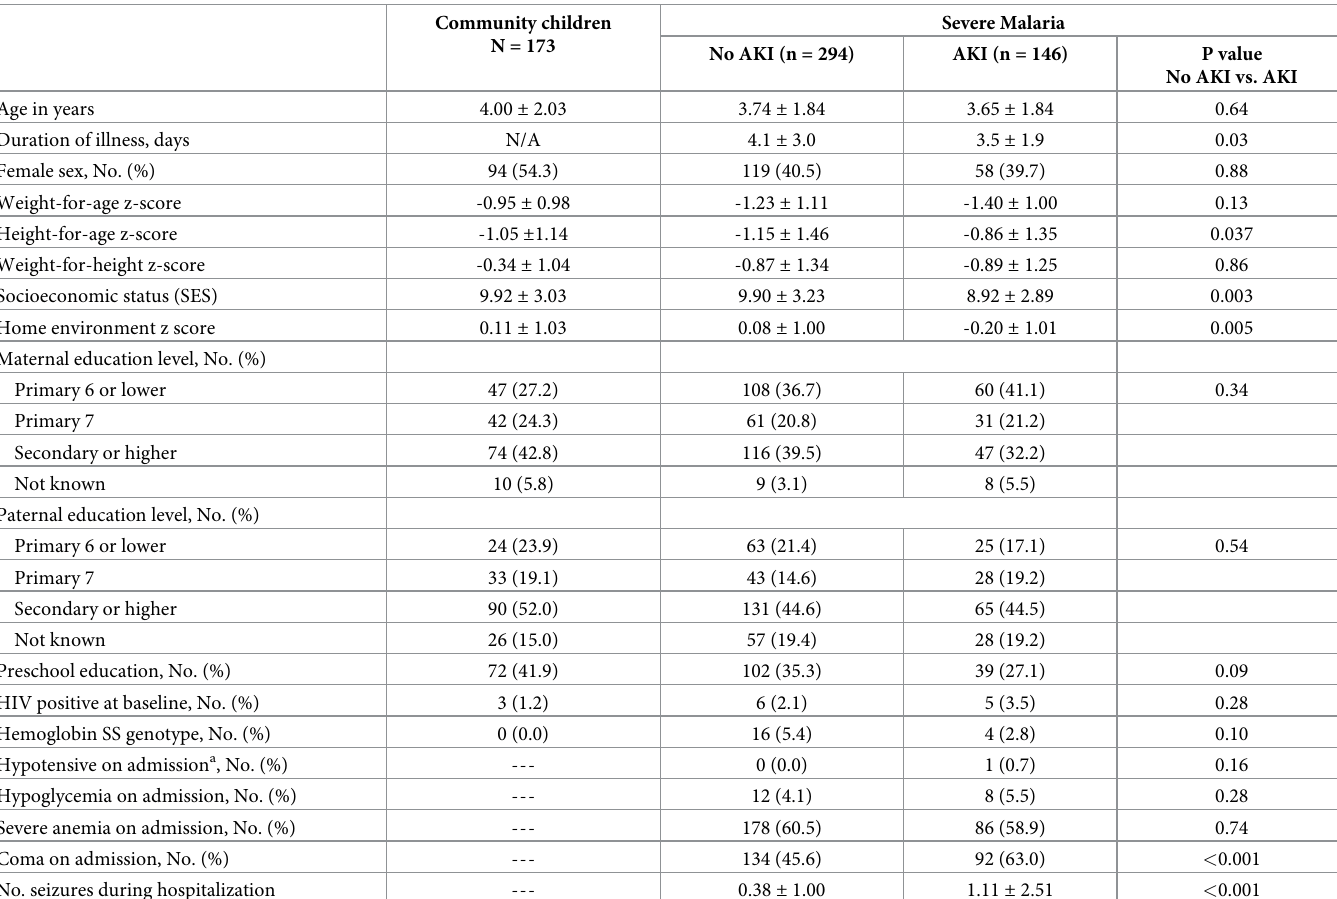
Table 1. Baseline characteristics of children with severe malaria by AKI